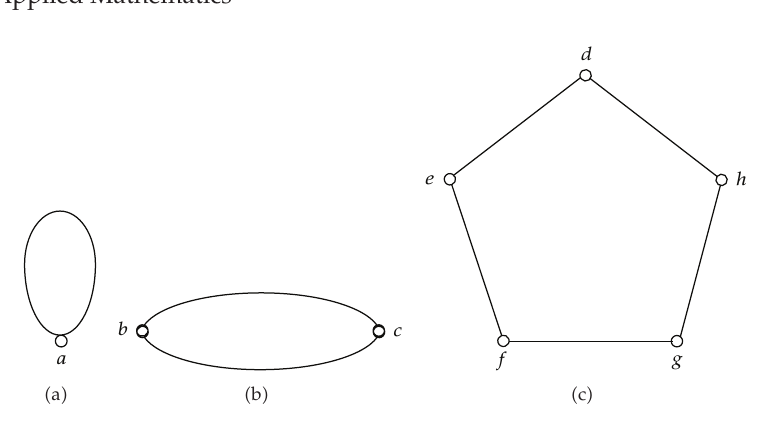
Figure 2: The cycles of equivalence classes.